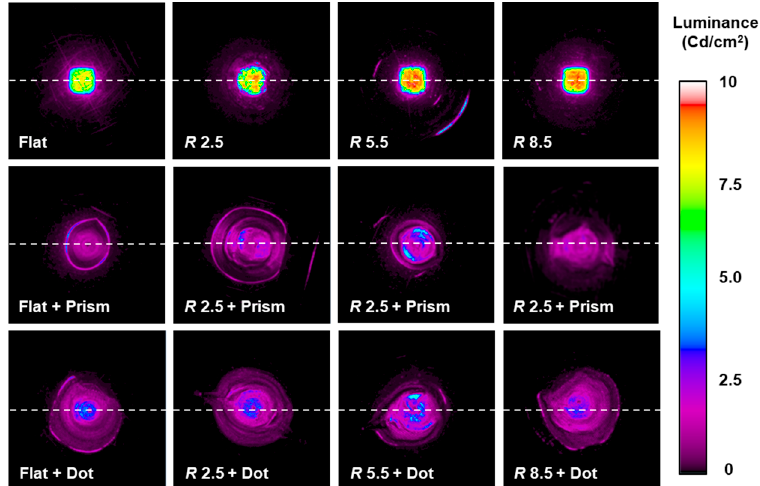
Figure 11. Comparison of light illumination characteristics of curved PET films with different curvatures and pattern types.